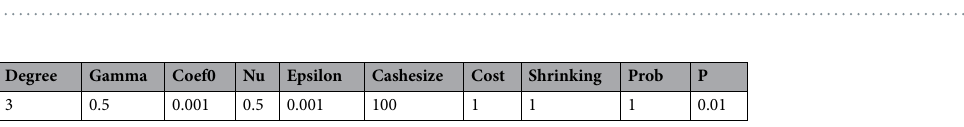
Figure 5. Scatter plots of the measured and predicted values of validation with BPNN 1( a ), 2( b ) and 3( c ) based on vegetation indices.